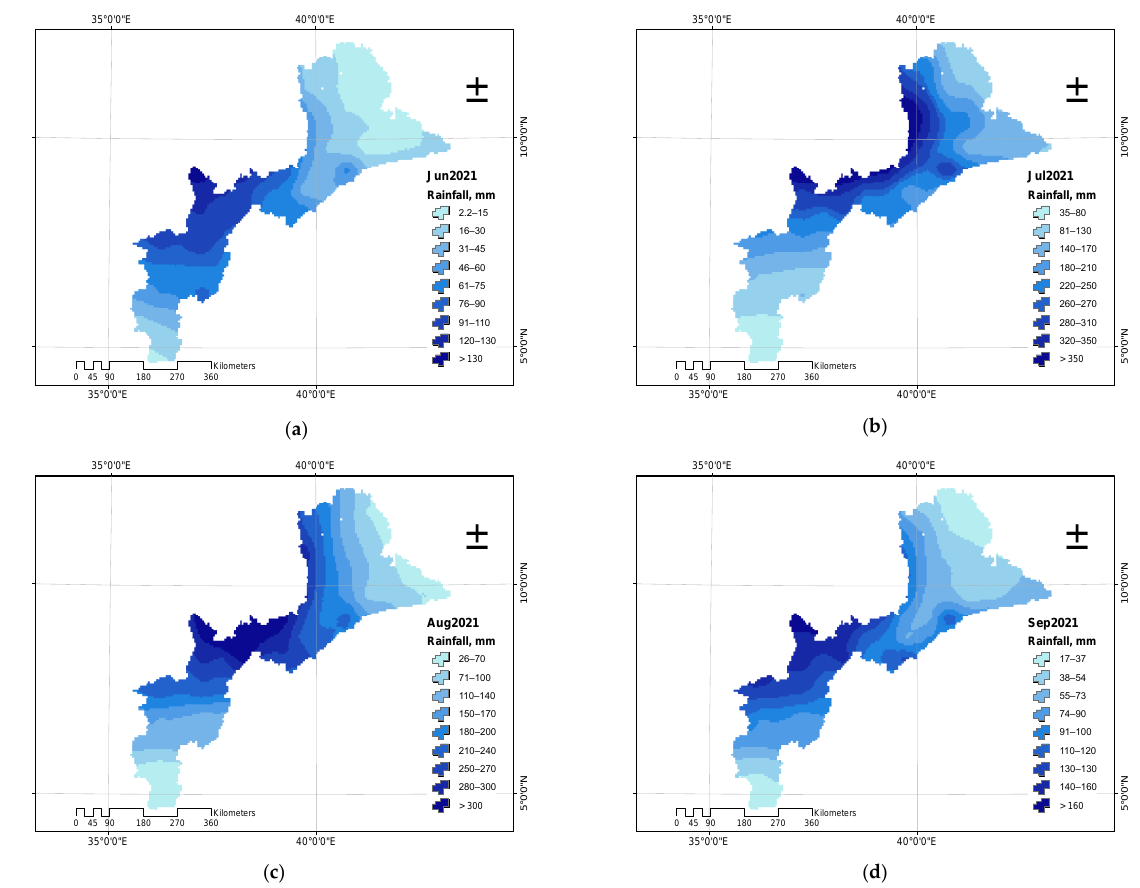
Figure 9. Spatial precipitation distribution for the 2021 flood season (June to September). ( a ) presents the precipitation distribution for the month of June; ( b ) presents the precipitation distribution for July; ( c ) presents the precipitation distribution for August; ( d ) presents the precipitation distribution for September.